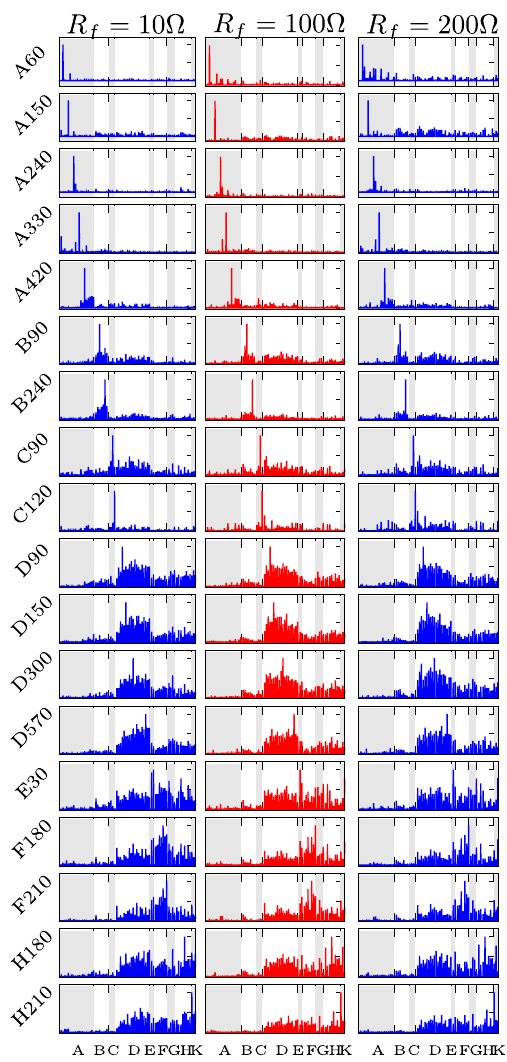
Figure 12. Normalized m 2 for various fault positions on the IEEE 13-bus network at an SNR of 40 dB. The margin is observed to deteriorate as the fault position moves further away from the fault point, but robust performance is still observed. In all cases, the correct fault location coincides with the highest point of the